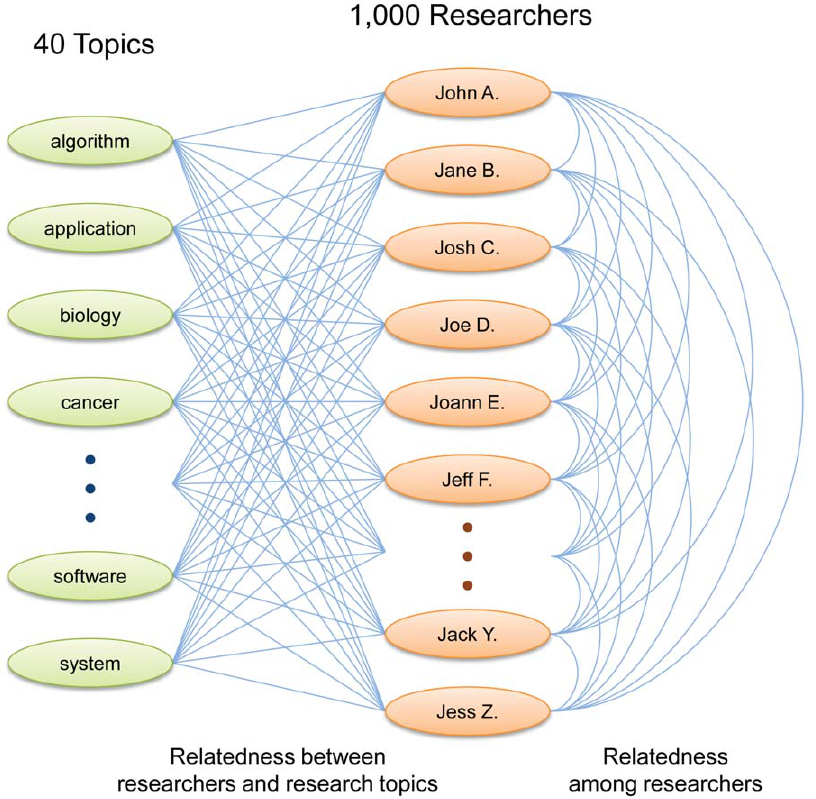
Figure 1. An overview of the network that consists of 1,000 researchers and 40 research topics reconstructed in this study. Each link is weighted by the average number of web search hits for a search query of (research topic) + (researcher’s name) + ‘‘research’’ (left), or (researcher’s